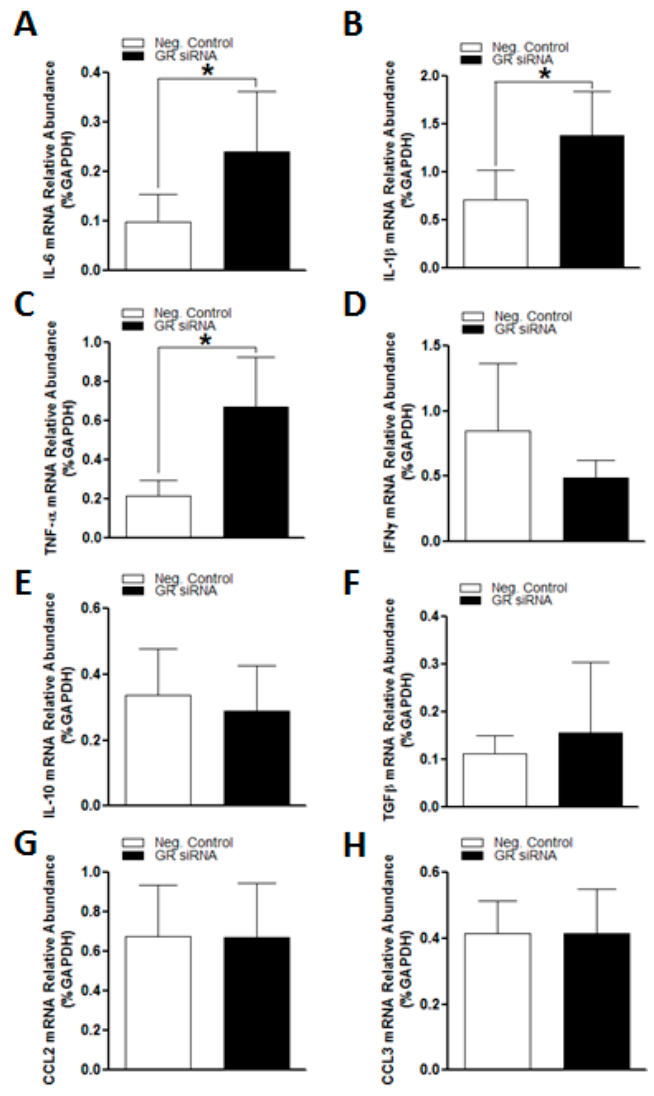
Figure 2. The GR repression increased expression of pro-inflammatory genes in mice brains before MCAO treatment. The mice received either GR siRNA (100 pmol) or its negative control (Neg. Control; 100 pmol) via intracerebroventricular (i.c.v.) injection. The brain samples were collected at 48 h after i.c.v. injection. No middle cerebral artery occlusion (MCAO) was conducted. Quantitative reverse transcription polymerase chain reaction (RT-qPCR) was utilized to assess inflammation-related genes expression profiles, including IL-6 ( A ), LI-1 β ( B ), TNF- α ( C ), IFN- γ ( D ), IL-10 ( E ), TGF- β ( F ), CCL2 ( G ) and CCL3 ( H ), respectively. n = 5. * p < 0.05, GR siRNA vs. Neg.